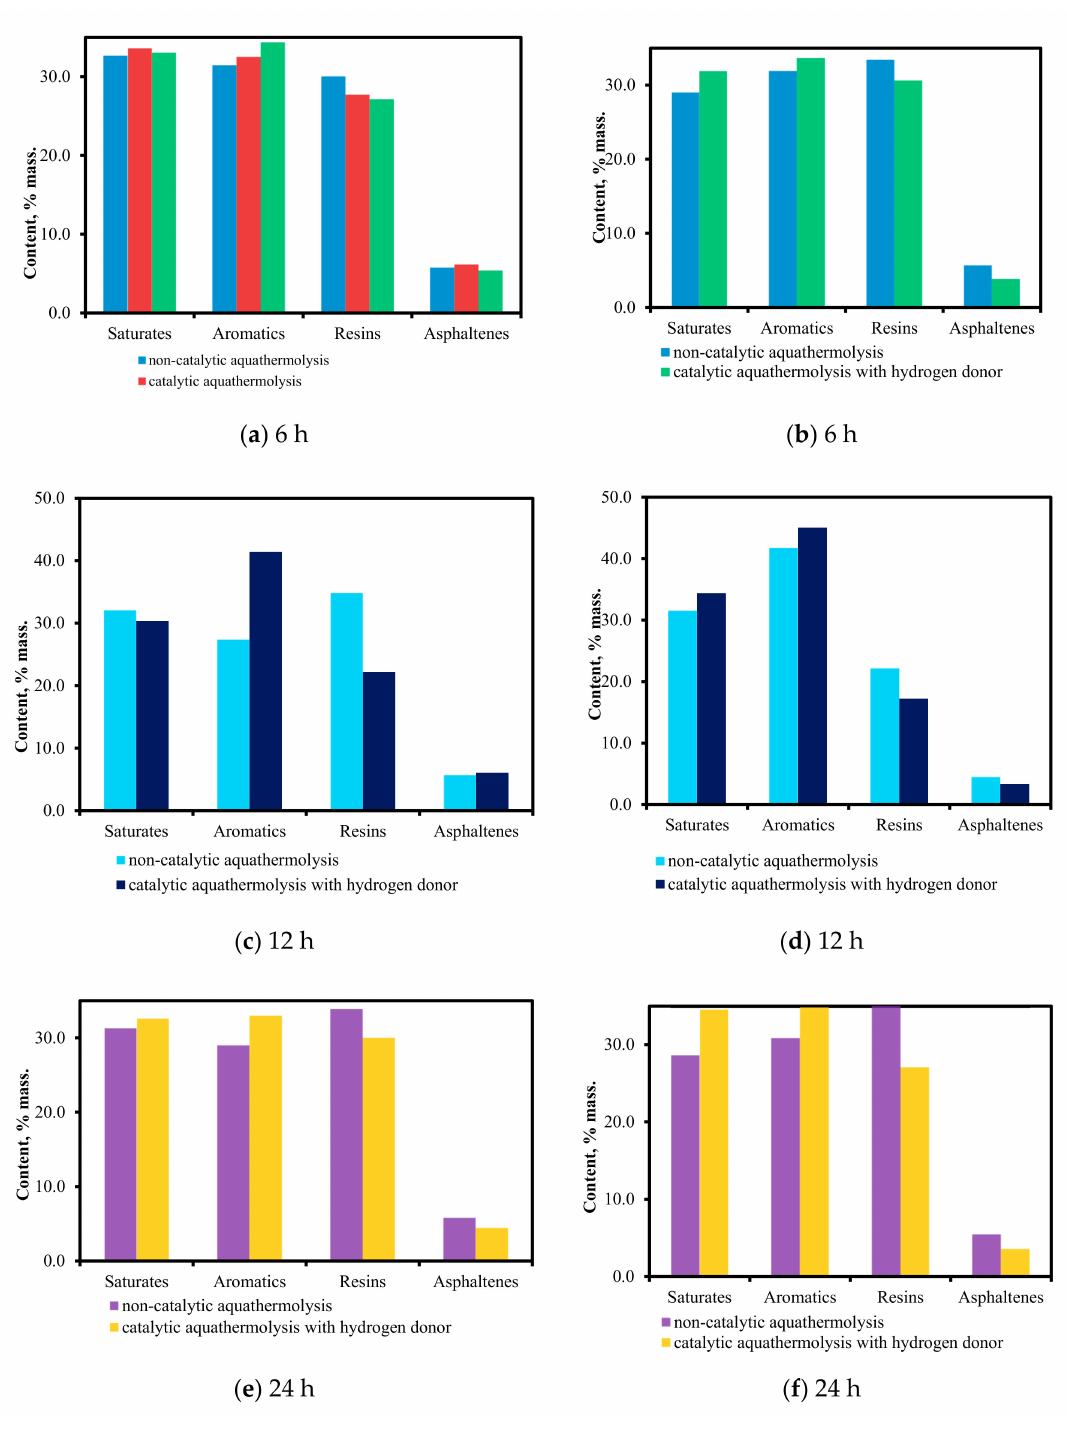
Figure 1. The group composition of non-catalytic and catalytic aquathermolysis products at 6 ( a ), 12 ( c ), and 24 h ( e ) (temperature 250 ◦ C); and at 6 ( b ), 12 ( d ), and 24 h ( f ) (temperature 300 ◦ C). Free radicals were formed after the thermal treatment of crude oil as heteroatoms containing bonds were cleaved. Such decomposition reactions are intensified due to the presence of